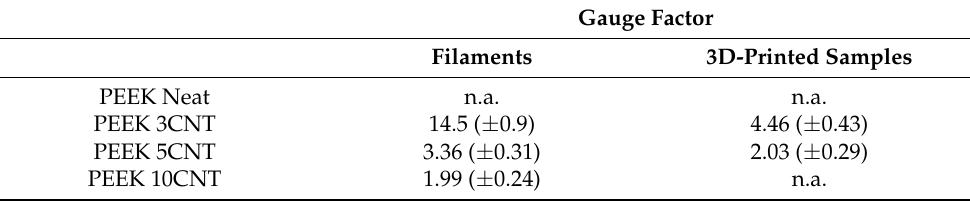
Table 1. Gauge factor for filaments and 3D-printed samples (with sample standard deviation).